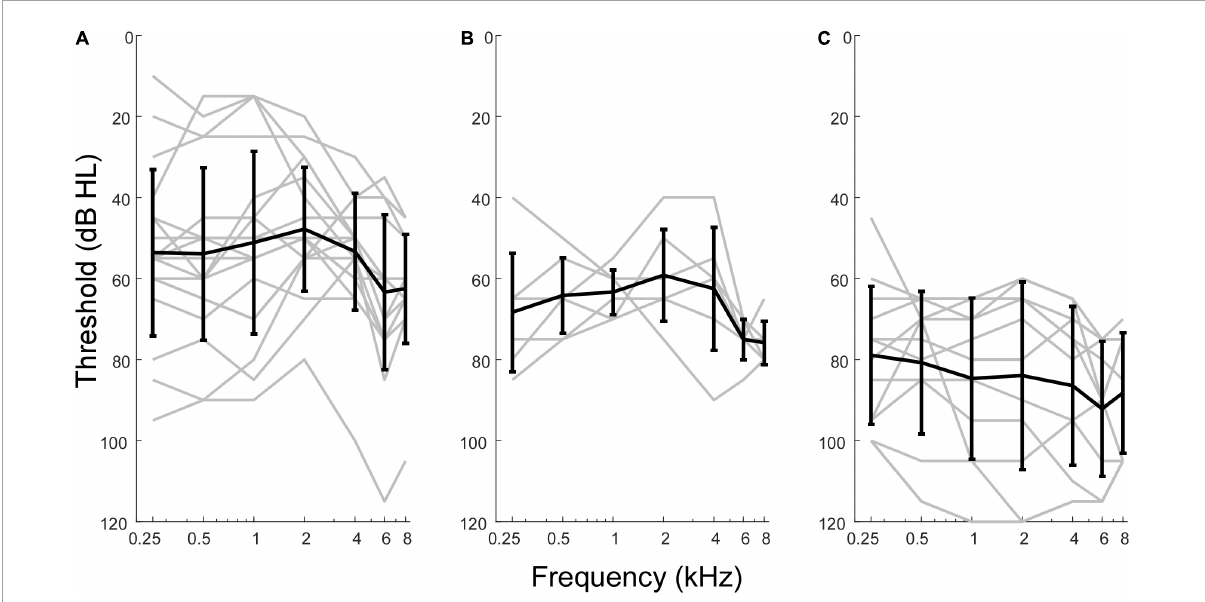
FIGURE2 Audiometric profiles of subjects with Meniere’s disease separated by type of surgical intervention. (A) Subjects undergoing hearing preservation procedures of endolymphatic sac decompression and shunt placement had thresholds closest to normal levels and greatest variability in audiometric thresholds. (B) Subjects undergoing labyrinthectomy had hearing loss between the other two operative groups. (C) Subjects undergoing cochlear implant procedures had thresholds indicative of most severe hearing loss overall.